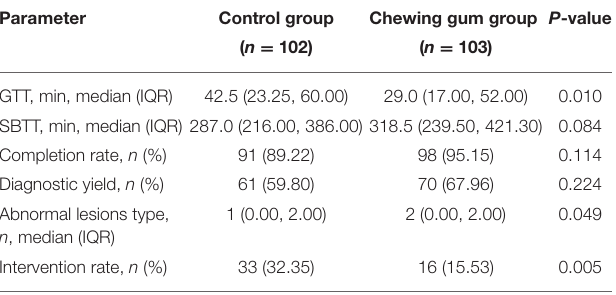
TABLE 2 | Effects of chewing gum on the outcomes of capsule endoscopy examination.